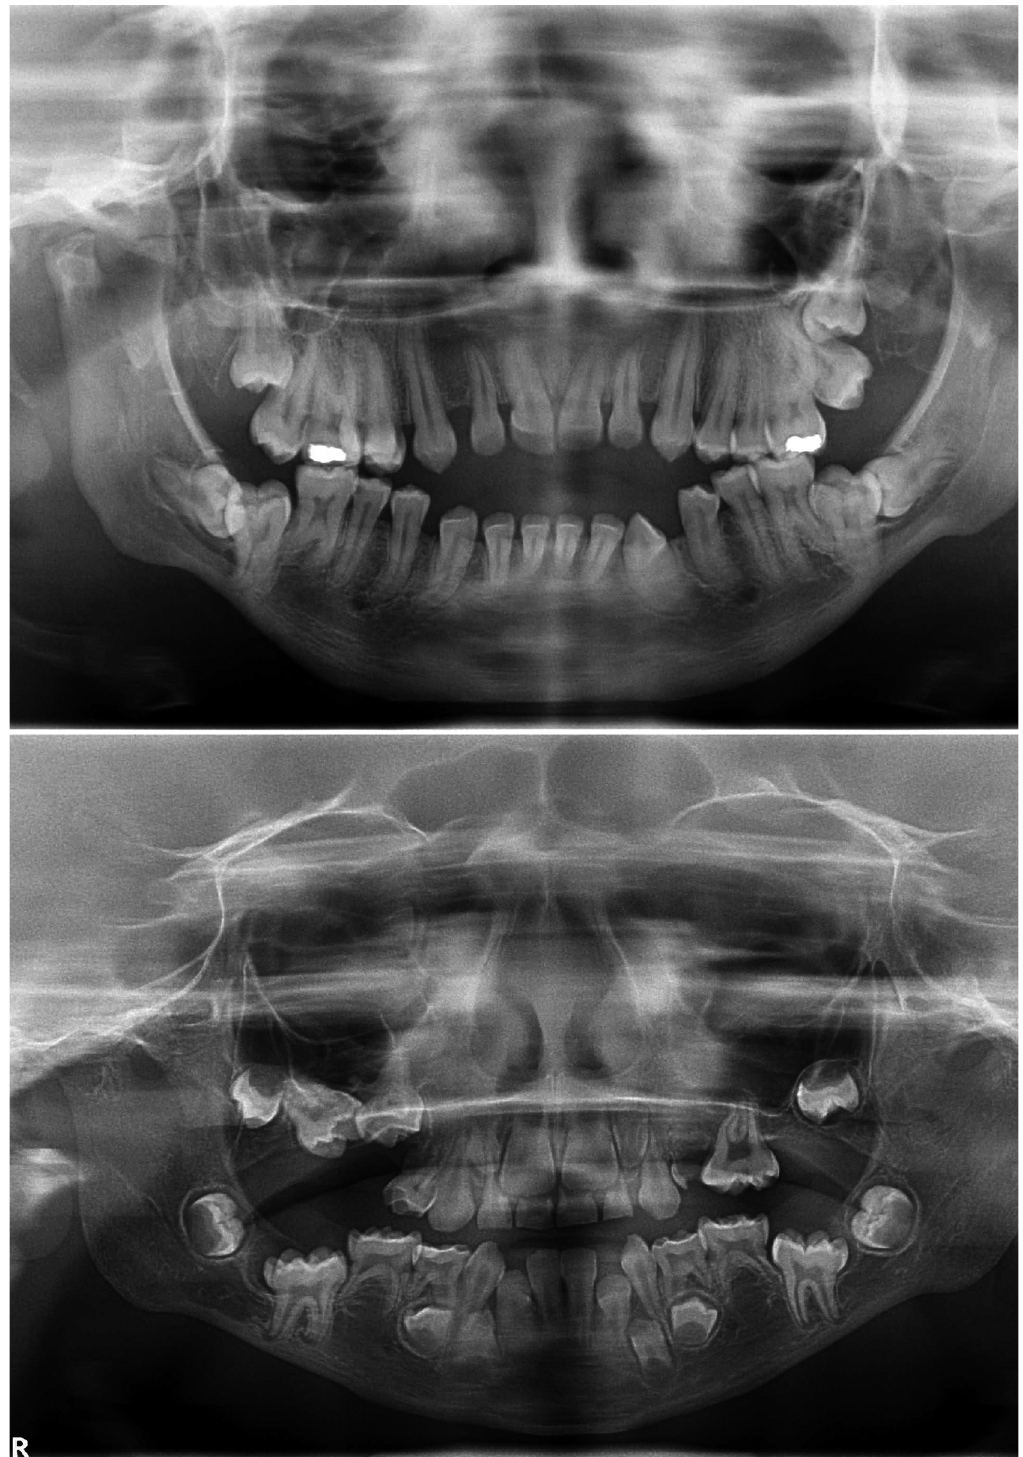
Figure 2- Panoramic radiographs of individuals with MPS type VI, aged 18 years old (A) and MPS type I, aged 6 years old (B), showing taurodontism, root dilaceration, tooth agenesis, and tooth